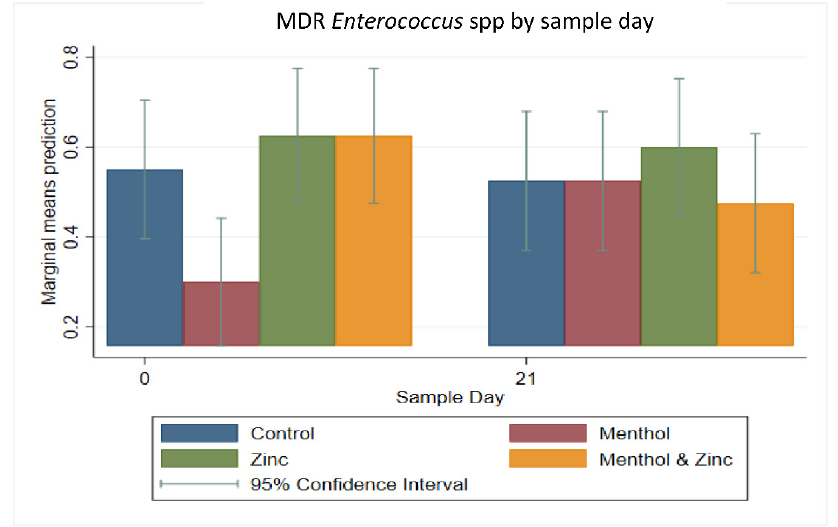
Figure 12. Marginal means with 95% confidence intervals of a 2 × 2 × 2 multi-level mixed logistic regression model, using factors of zinc, menthol and sample day on the binary outcome of MDR Enterococcus spp.